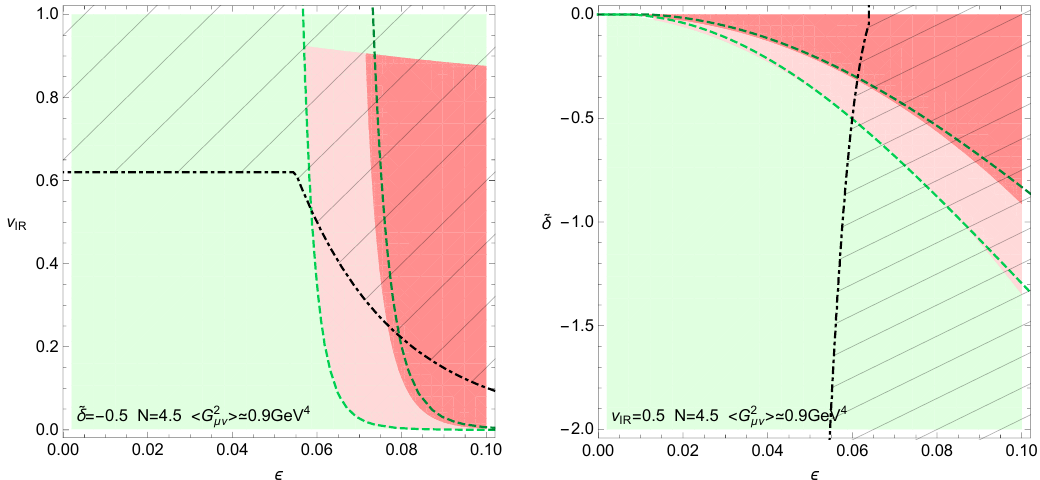
Figure 5 . Results for (cid:22) min = 2 : 5 TeV, N = 4 : 5 and n = 0 : 1 and n = 0 : 3 when the QCD e(cid:11)ect is included. For the left panel, we have (cid:12)xed ~ (cid:14) = (cid:0) 0 : 5, and for the right panel, v where the phase transition can complete via the nucleation of O (4)-symmetric bubbles for both n = 0 : 1 and n = 0 : 3 are shown in green. This to be compared with the allowed regions in (cid:12)gure 4 without the QCD e(cid:11)ect. Regions where the nucleation rate is too low are colored in pale (dark) red for n = 0 : 3 ( n = 0 : 1). The corresponding green dashed lines delimit the region satisfying eq. (6.5), where we expect the QCD e(cid:11)ect to be important. In the hashed region (above the black, dashed line in the left panel and to right of the black, dashed line in the right panel), the backreaction constraint is not ful(cid:12)lled. The radion masses are as in (cid:12)gure